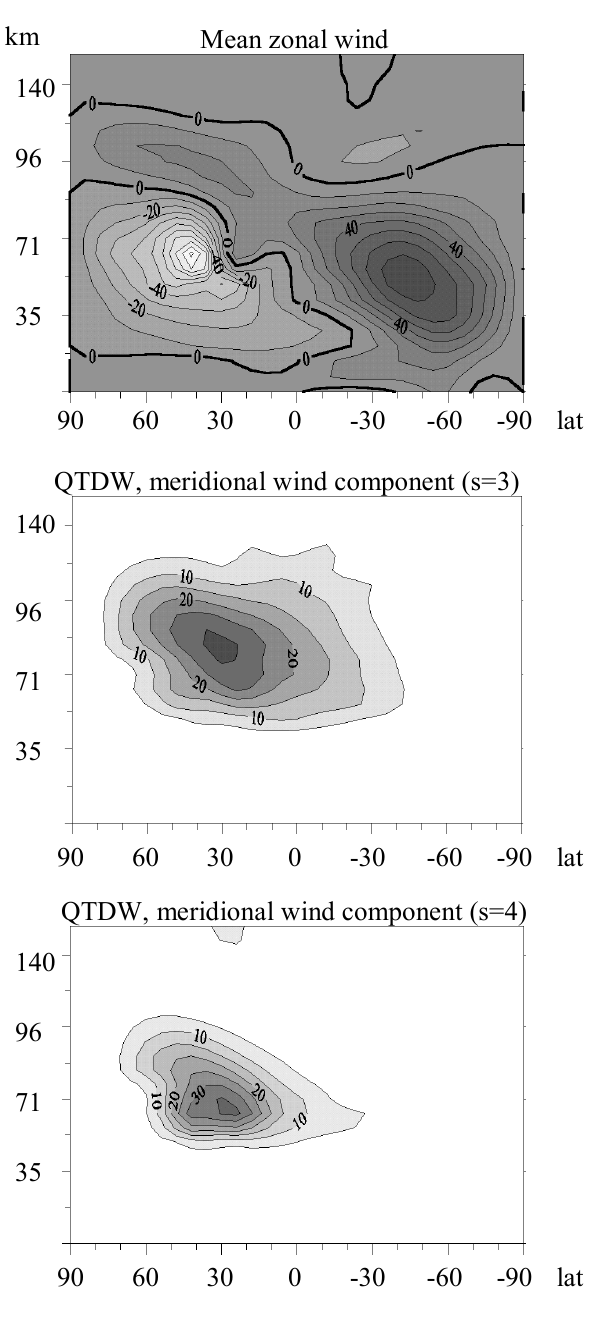
Fig. 5. Distributions of mean zonal wind and meridional wind am- plitudes of waves s=3 and 4. Amplitudes are given in m/s. Axis labels are latitude and approximate